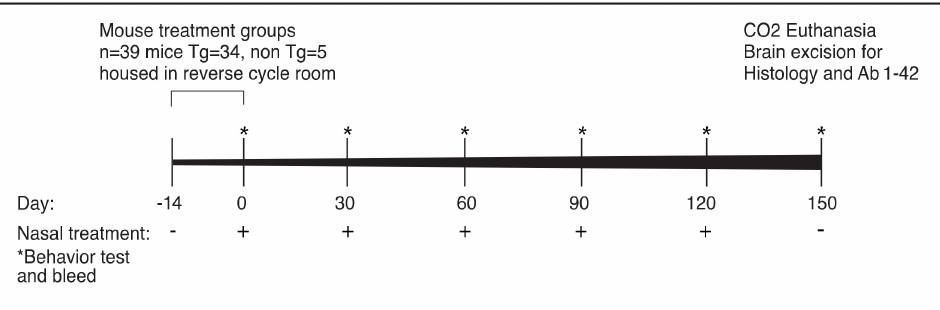
Figure 3. In order to test our peptides in vivo, we moved our experimental mice to a reverse cycle room 2 weeks prior to the beginning of treatments and tests. The animal model used was 5xFAD APP Tg, or 5xFAD mice crossed with Tau Tg mice 5xFADXTau (FT). Mice were tested before the